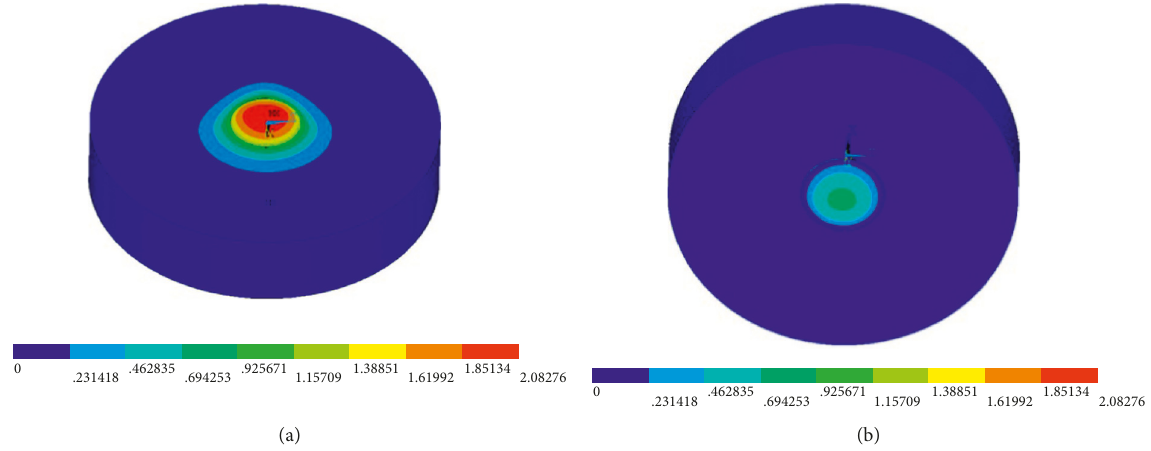
Figure 8: Slip clouds of the (a) loading and (b) free ends of the